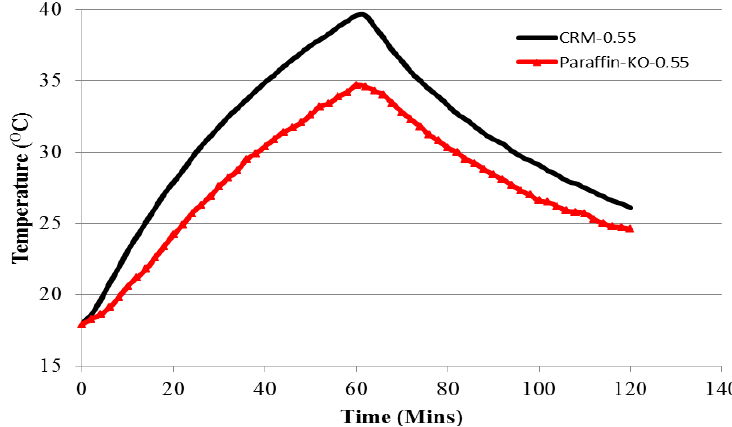
Figure 11. Indoor temperature variation at the center of the room model—Control and Paraffin-Kaolin composite room model.